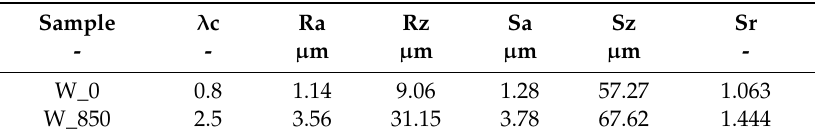
Table 6. Roughness characteristics of 316L–40MgO composite substrates according to ISO 25178-2-2020 and DIN EN ISO 4287 [40,42].